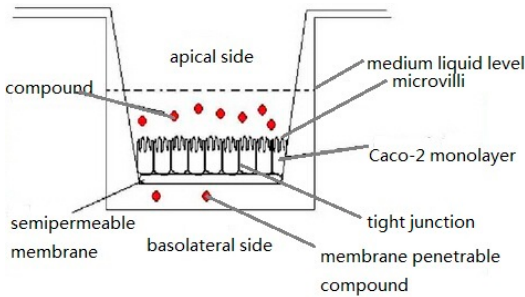
Figure 5. The Caco-2 cell permeability method.